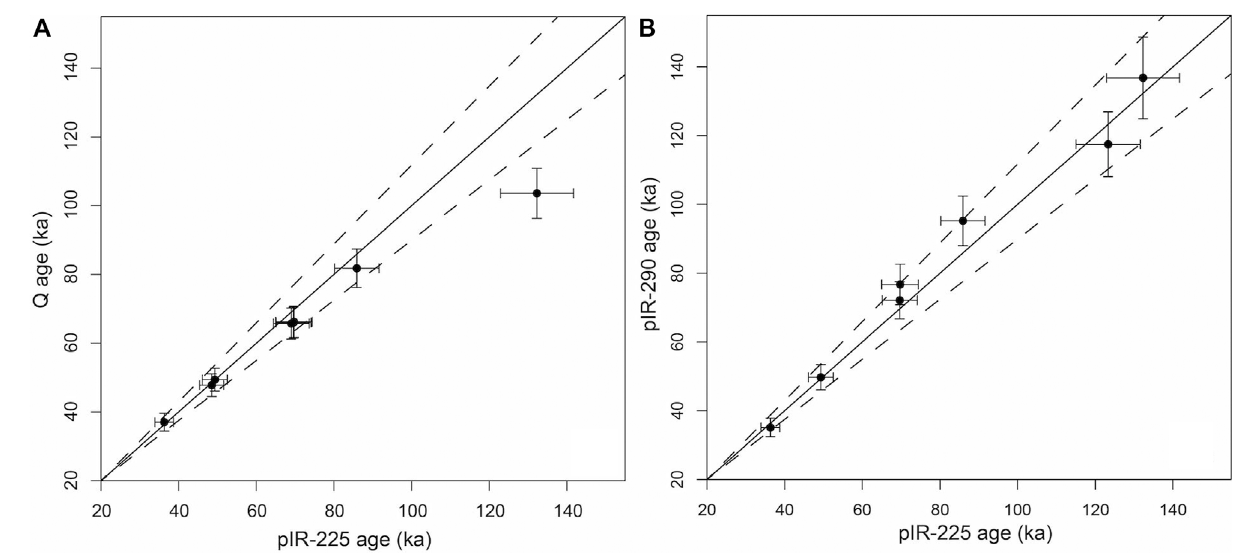
FIGURE5| Comparisonofluminescenceages,comparing (A) quartz fi negrainageswithpIRIR-225polymineral fi negrainages,and (B) pIRIR-225andpIRIR-290 polymineral fi ne grain ages. The dotted lines indicate 10% deviations from the 1:1 line.